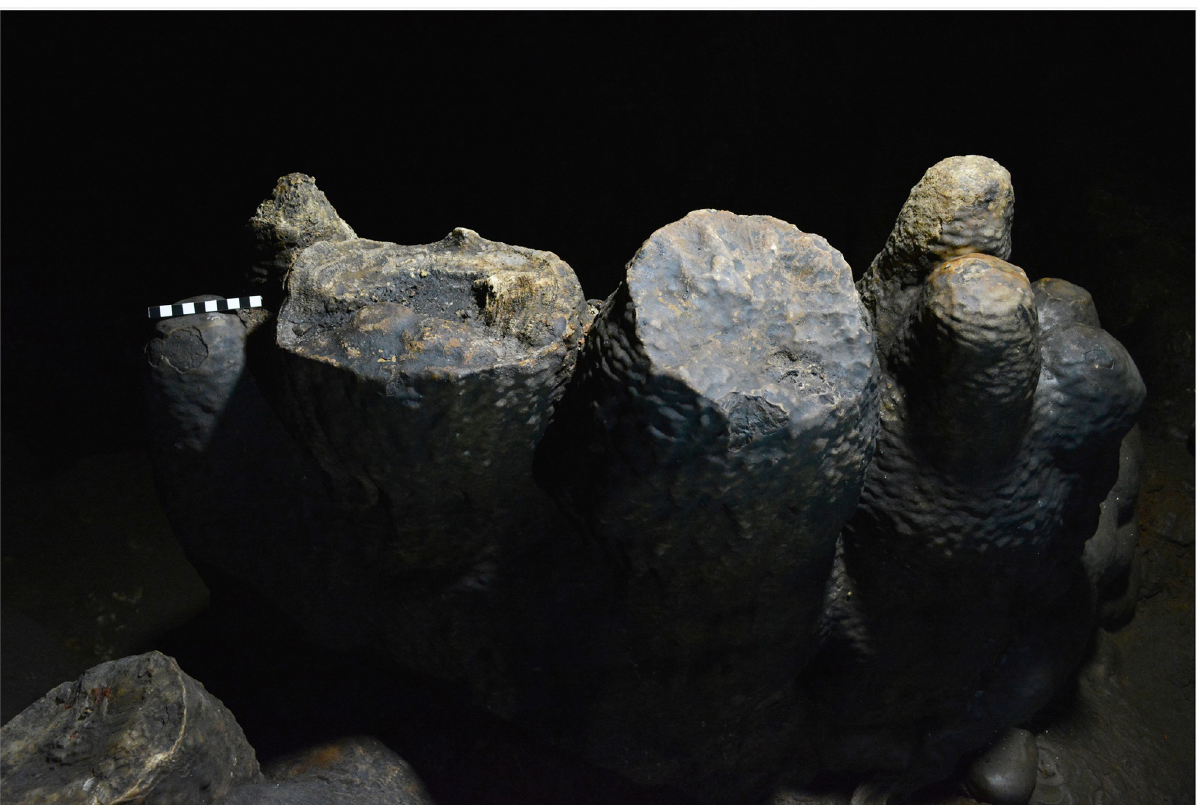
Fig 16. Capped stalagmite used as a stationary lamp during the Epipalaeolithic.